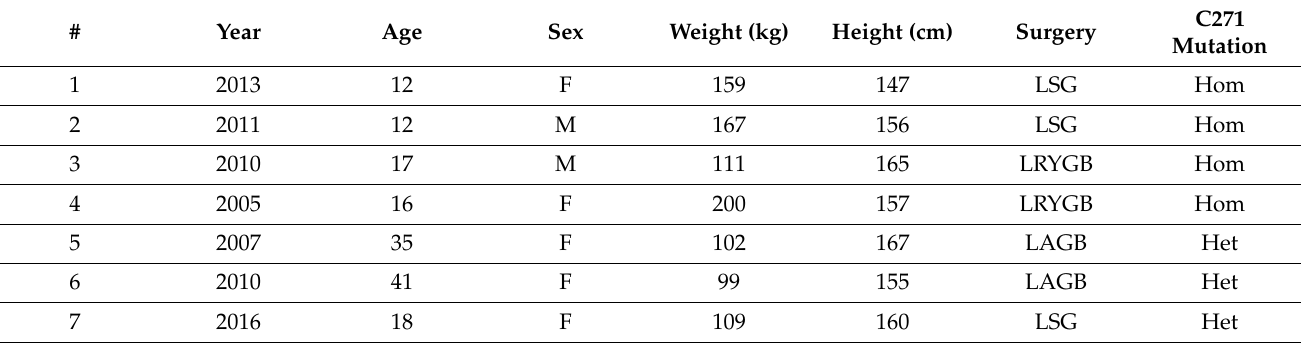
Figure 1. Pedigree of the patients in the study. The numbers indicate the patient number. Dashed lines denote that patients are cousins. Black circles denote homozygous females, black squares denote homozygous males, and half-filled circles denote heterozygous females. The genotype of the spouse of patients 5 and 6 is not known, but the marriage is consanguineous. Table 1. Anthropomorphic and genetic parameters of the patients before primary bariatric surgery. LAGB: laparoscopic adjustable gastric banding; LSG: laparoscopic sleeve gastrectomy; LRYGB: laparoscopic Roux-en-Y gastric bypass.